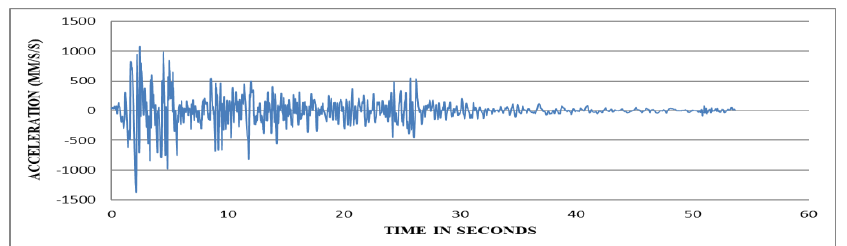
Figure 4. Base-isolated stiffer models. ( a ) Experimental setup; ( b ) schematic diagram.